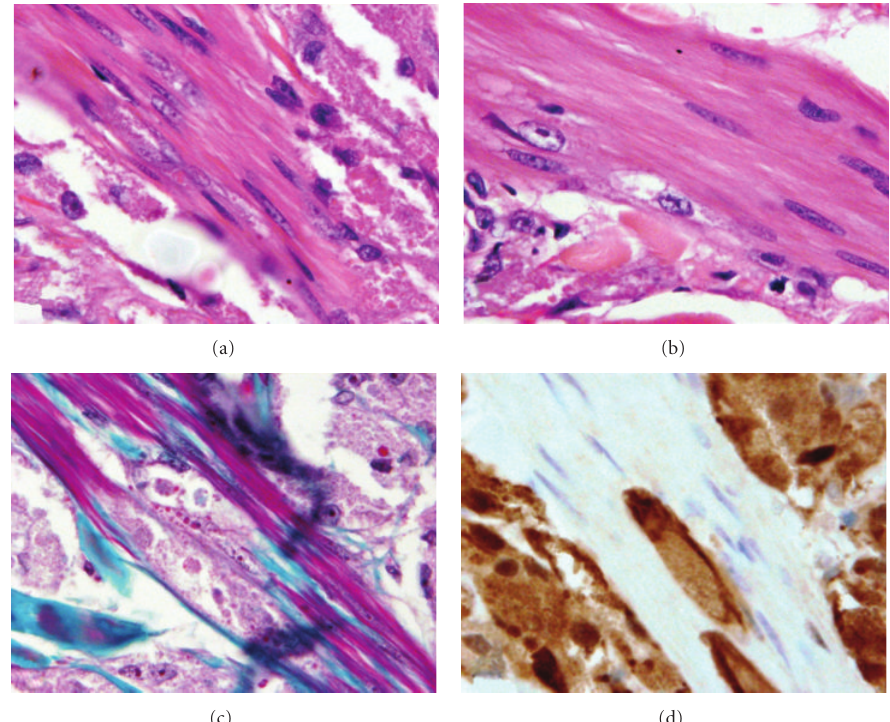
Figure 3: The erector pili muscle is characteristically infiltrated by the tumor cells: H&E (a and b), Masson Trichrome (c), and S100 stain (d) ( ×